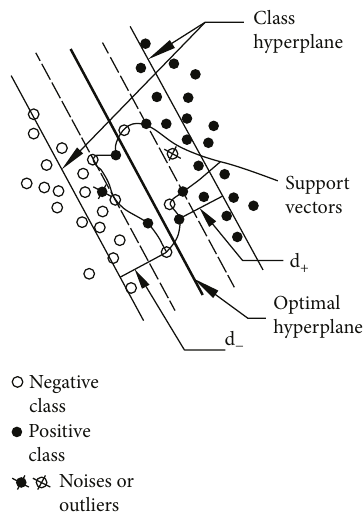
Figure 1: Scheme of SVM and FSVM (for 2-dimensional